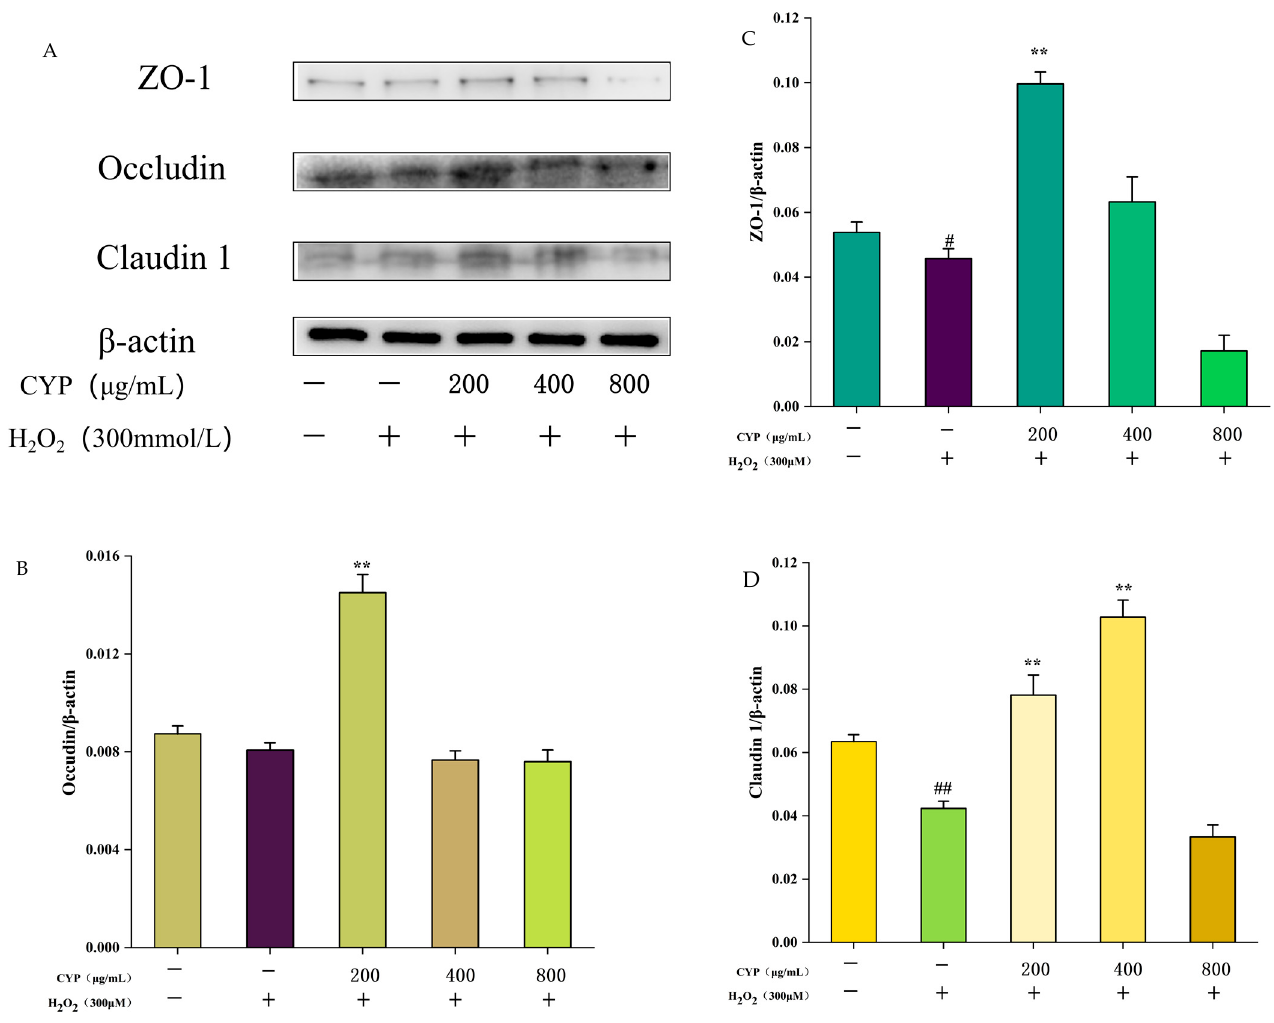
Figure 6. Effects of CYP on ZO-1, Occludin, and Claudin-1 levels of H 2 O 2 -induced IEC-6 cells. ( A ) Western blot showing the protein expression of ZO-1, Occludin and Claudin-1 in IEC-6. ( B – D ) The quantification of Occludin, ZO-1, and Claudin-1 expression. Results shown are expressed as means ± SD (n = 3). # p < 0.05, ## p < 0.01 compared with normal group, ** p < 0.01 compared with H 2 O 2 group alone.